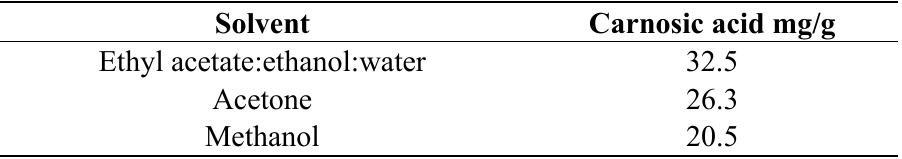
Table 3. Carnosic acid from rosemary using different extraction